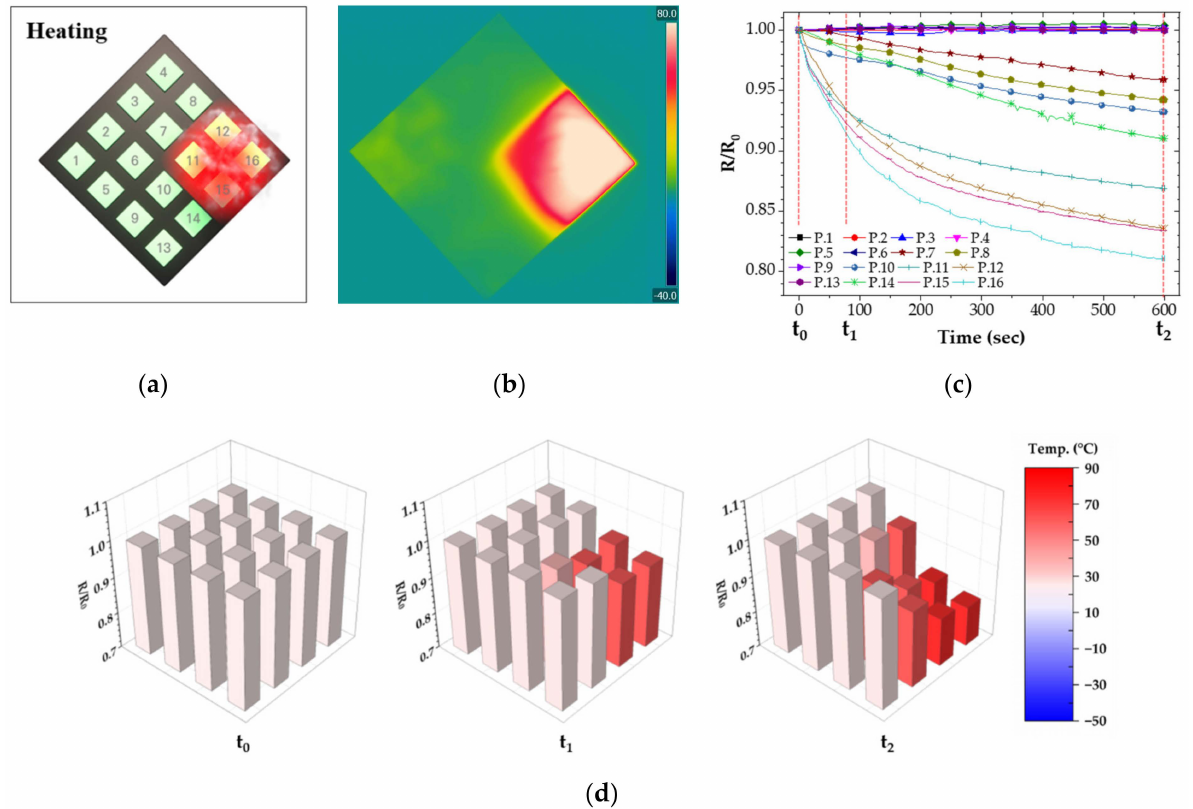
Figure 7. Resistance of CNT/EP coating according to partially heating; ( a ) measured points and applied area; ( b ) infrared thermal image; ( c ) normalized resistance; ( d ) normalized resistance at t 0 , t 1 , t 2